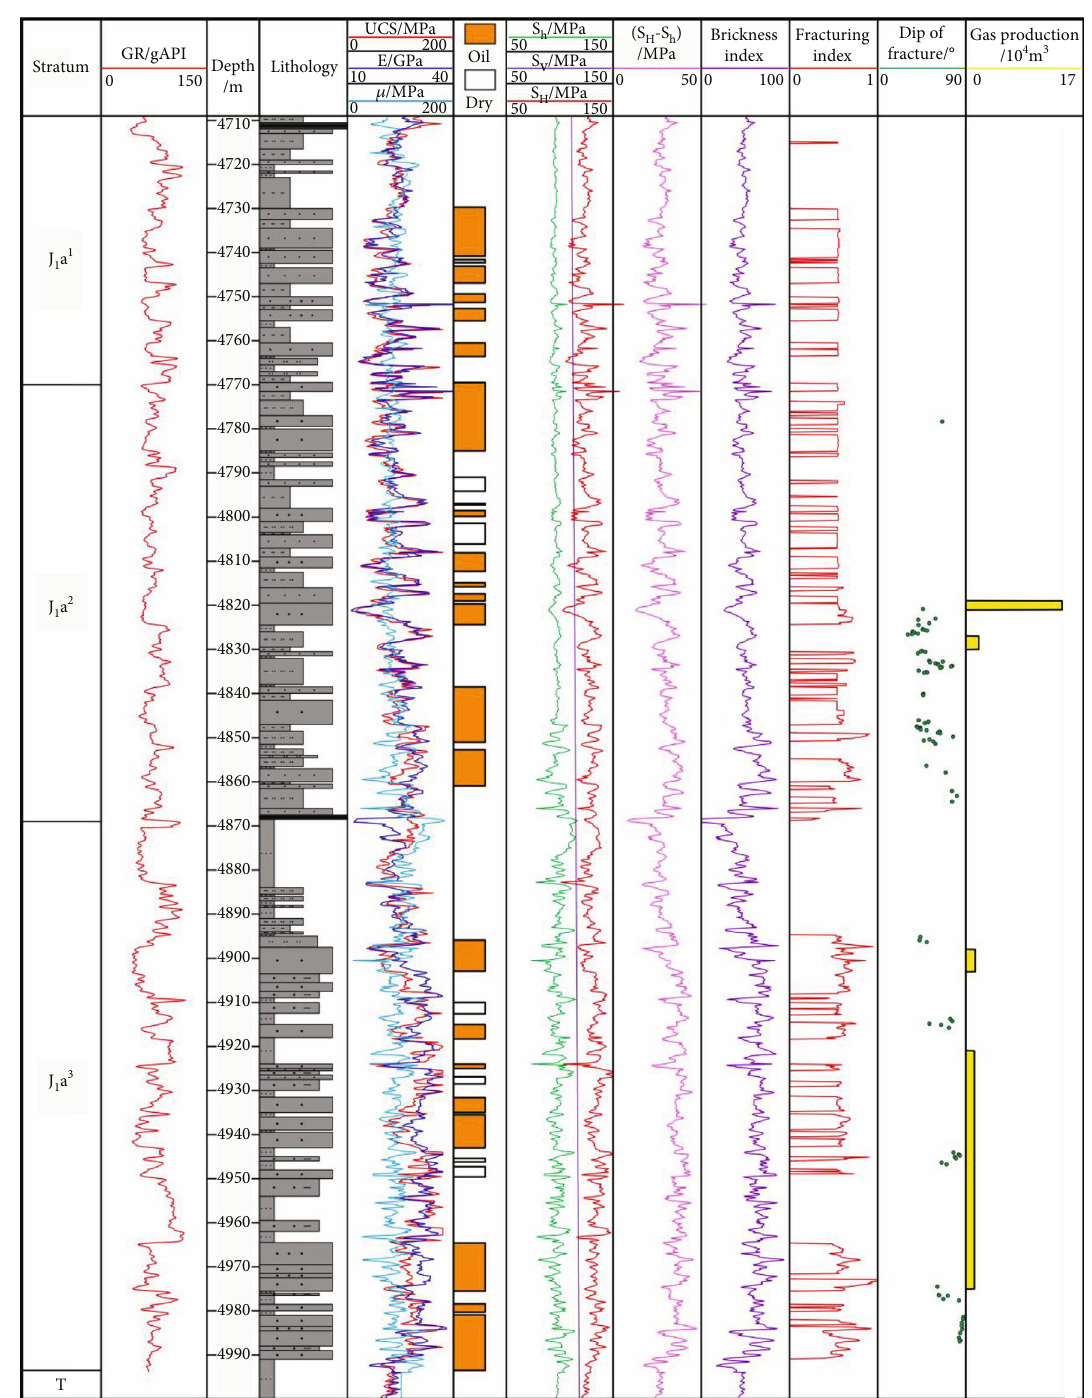
Figure 10: Geomechanical histogram of Well